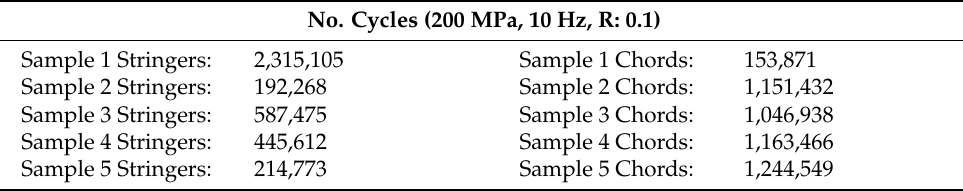
Table 6. Results Bemb é zar: number of cycles under fatigue dynamic test (10 Hz, R:0.1).